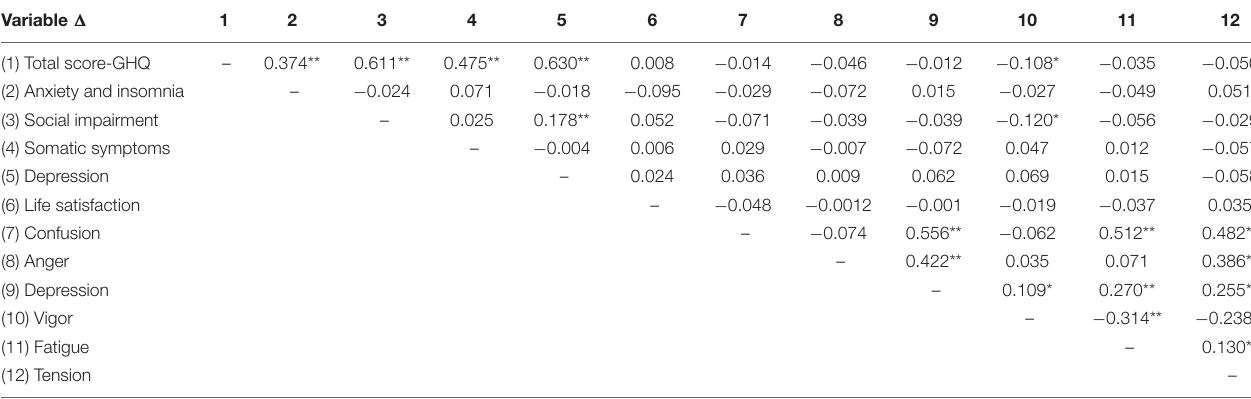
TABLE 4 | Correlation among mental health, mood states and life